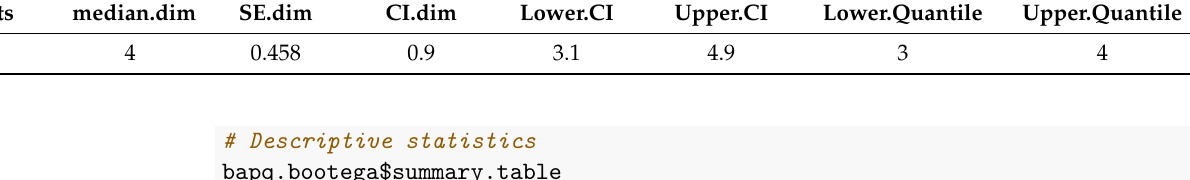
Table 1. Descriptive statistics of BAPQ dimensions across all bootstrap replicate samples. n.Boots median.dim